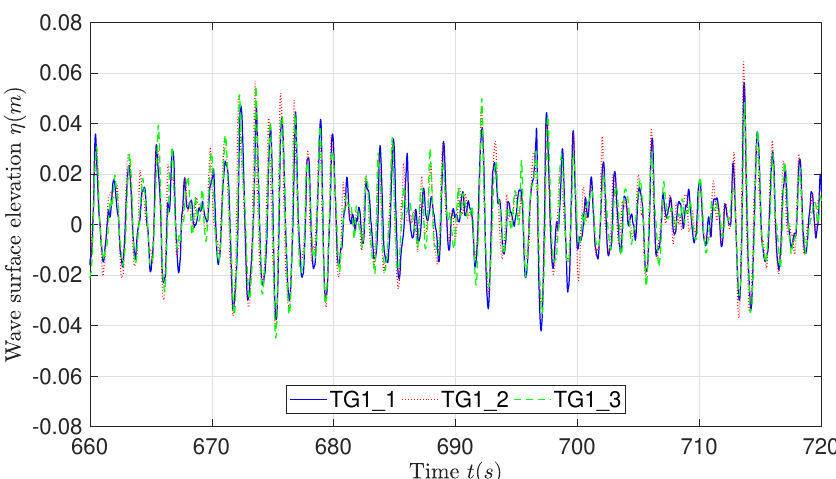
Figure 4. Repeatability of measured wave surface elevation (TG1_1 to TG1_3).